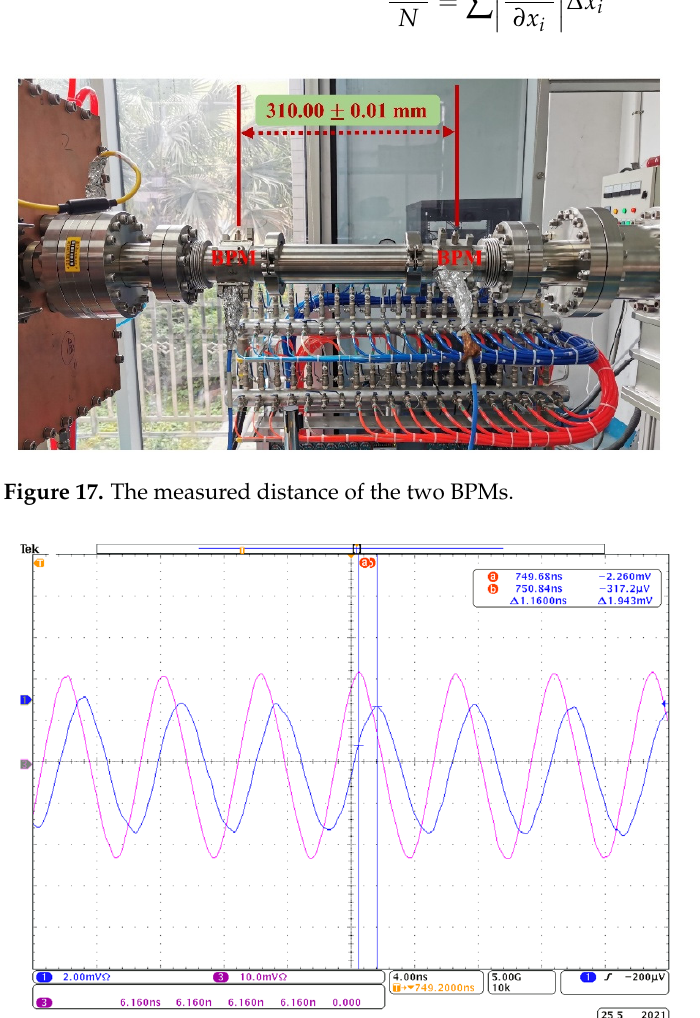
Table 2. Main parameters of the deuteron RFQs in the world.